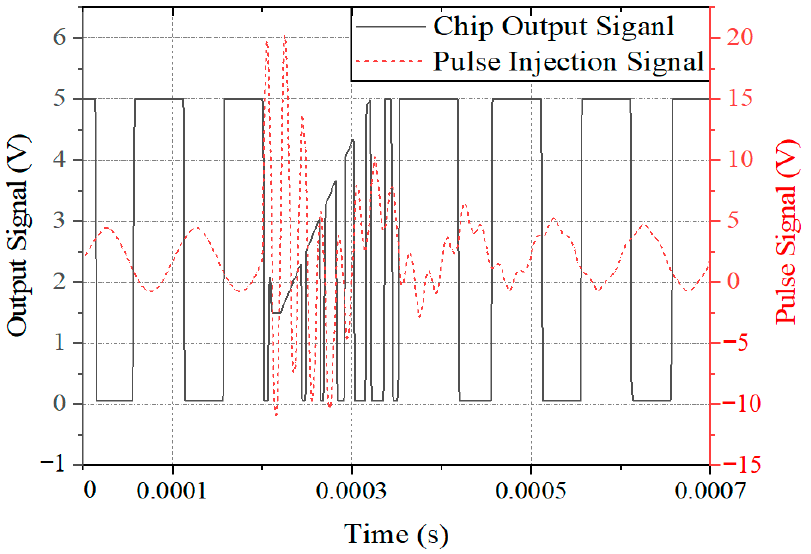
Figure 14. The monitoring signal of the speed acquisition chip port.